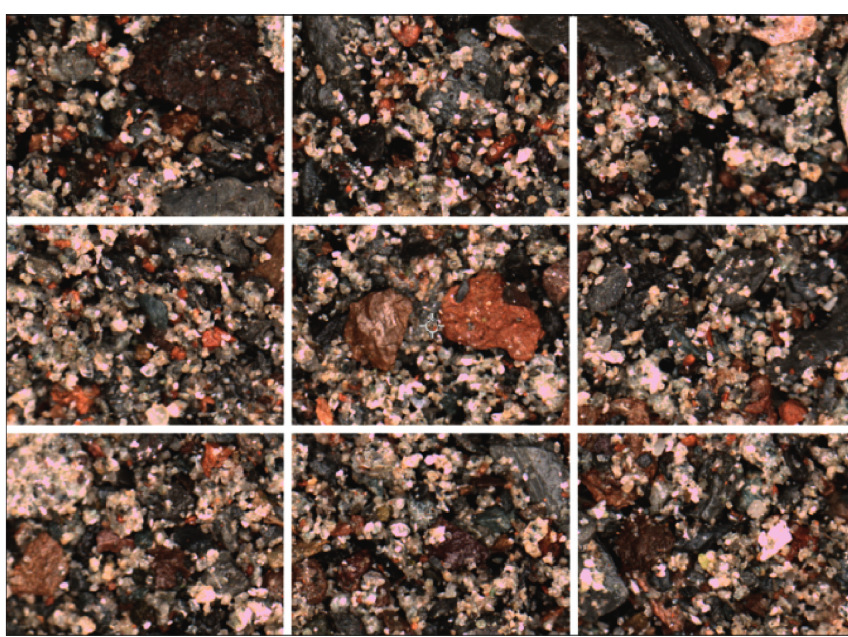
Figure 11: Image segmentation diagram. The image is divided into 3 ∗ 3 subgraphs on ensemble learning using the voting method.